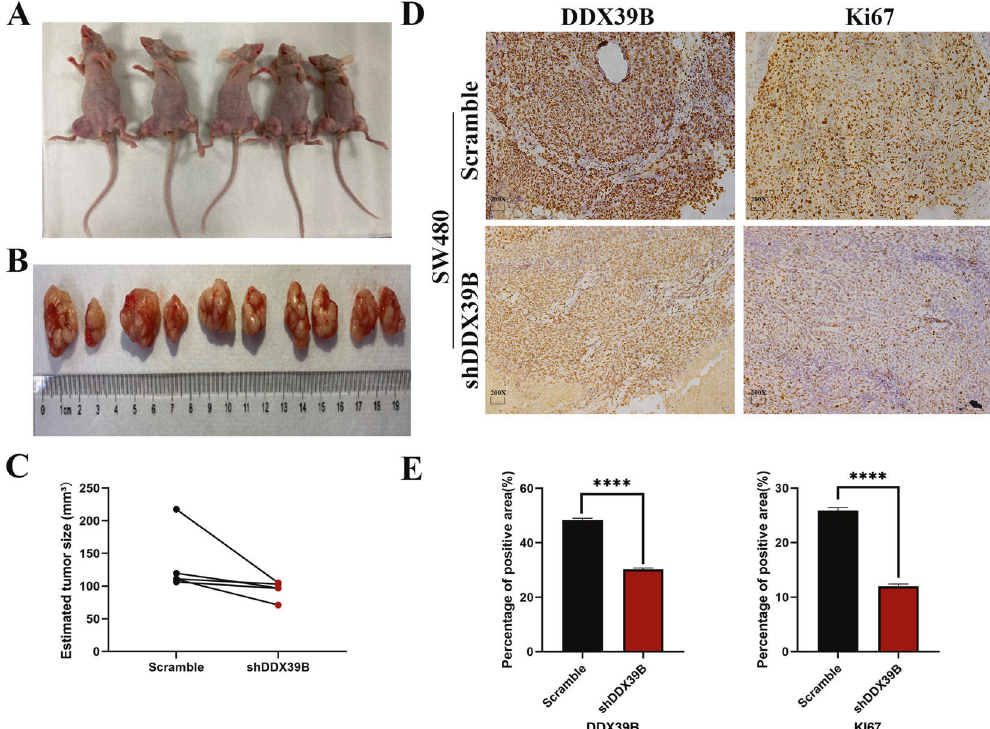
Fig. 3 DDX39B promotes the proliferation of colorectal cancer in vivo. A SW480/Scramble and SW480/shDDX39B cells were injected into nude mice. B Images of the subcutaneous tumors that were injected into the nude mice were obtained. C the weight of the tumors were estimated by the Scattergram (paired samples t -test). D , E Immunohistochemistry staining images of DDX39B in tumors were obtained then the positive area was calculated by the ImageJ, and the bar chart was used to demonstrate the DDX39B and Ki67 expression (one-sample t